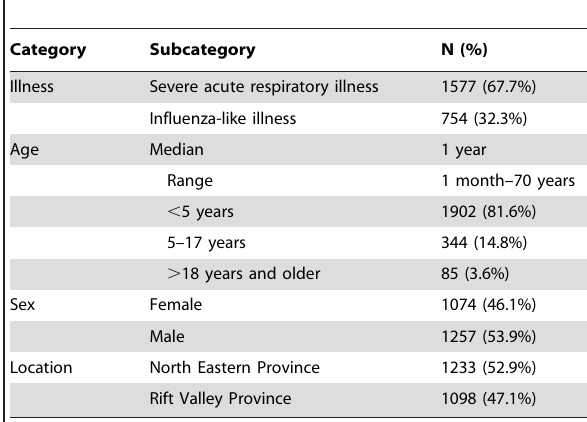
Table 3. Demographic characteristics of 2331 patients with influenza-like illness and severe acute respiratory illness from whom paired nasopharyngeal and oropharyngeal swabs were collected – Kenya,